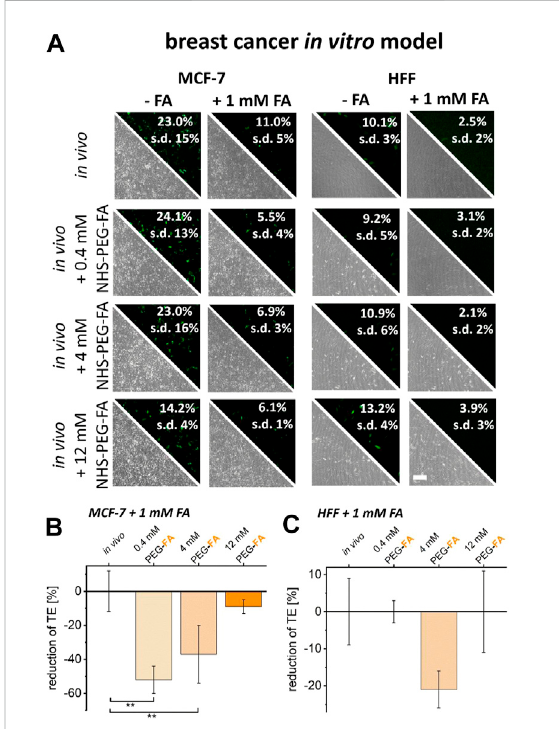
FIGURE 5 Reduction of FA binding capacity and the impact on transfer ef fi ciencies of FA functionalized lipoplexes. To reduce the uptake capacityofFA-functionalizedlipoplexes,cancercells(MCF-7)and healthy HFF cells were pre-incubated with 1 mM FA. The resulting transfer ef fi ciencies were analyzed by fl uorescence microscopy and fl ow cytometry (A) . The reduction in transfection ef fi ciencies of FA-functionalized lipoplexes was characterized comparatively between unmodi fi ed in vivo protocols and PEG-FA functionalized lipoplexes (0.4 – 12 mM) for cancer cells (B) and healthy cells (C) . Effects were normalized to the in fl uence of free FA incubation on the in vivo protocol. Scale bar 200 μ m. n = at least three independent experiments.